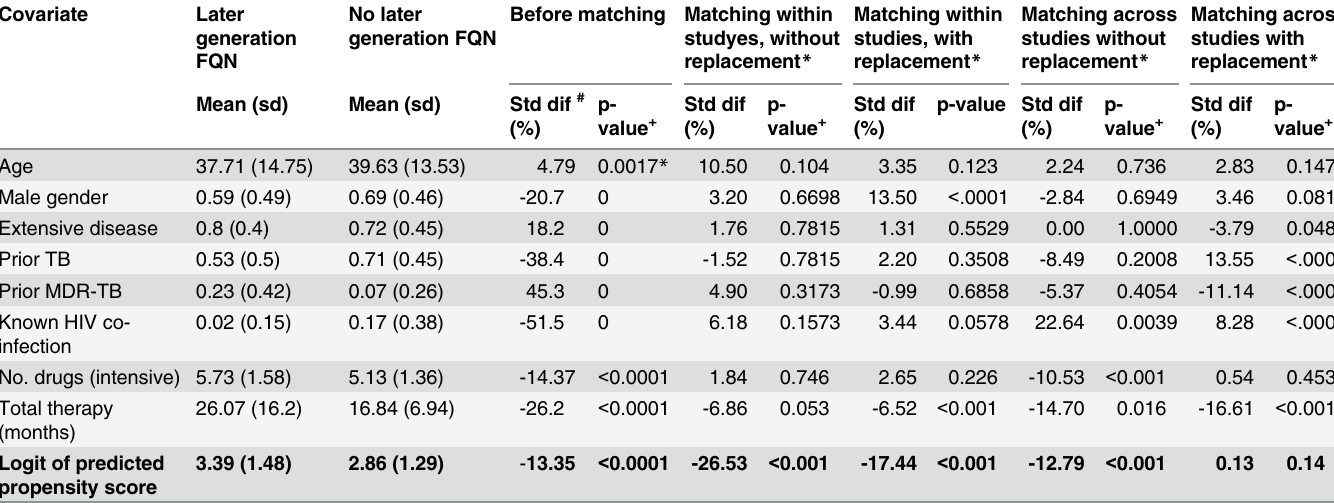
Table 5. Balancing achieved by different propensity score-based matching strategies for later generation fluoroquinolone use. Covariate Later No later Before matching Matching within Matching within Matching across Matching across generation generation FQN studyes, without studies, with studies without studies with FQN replacement * replacement * replacement * replacement *